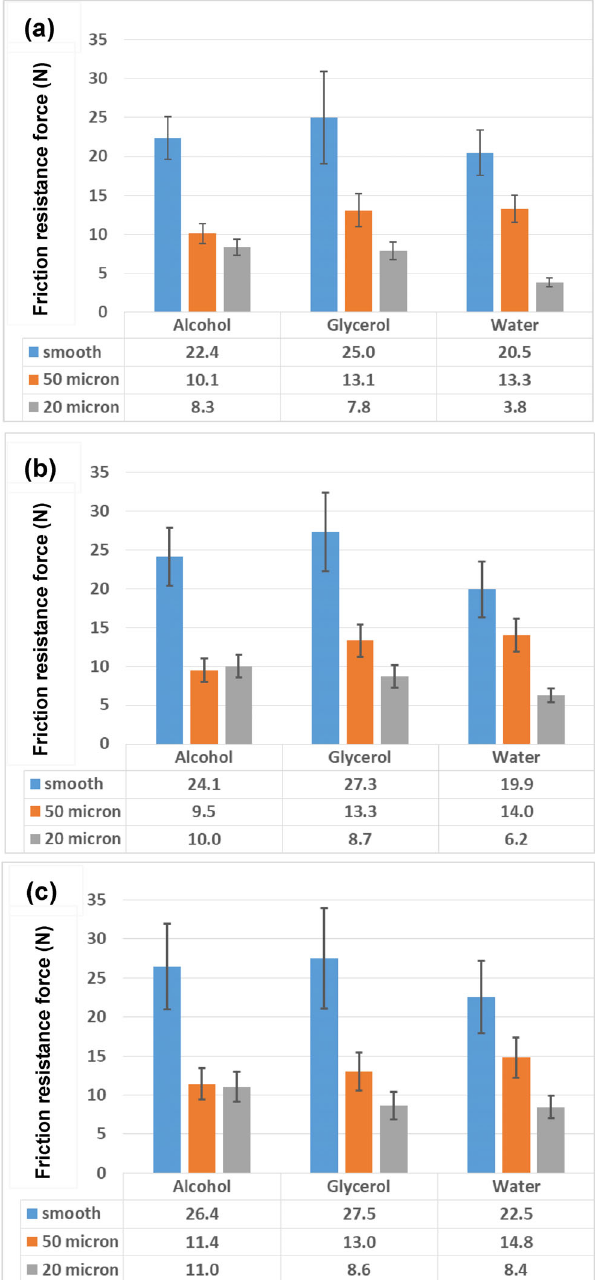
Fig. 6 Average friction resistance force F R and error bars for the three plungers at sliding velocity (a) 2.5, (b) 5, and (c) 10